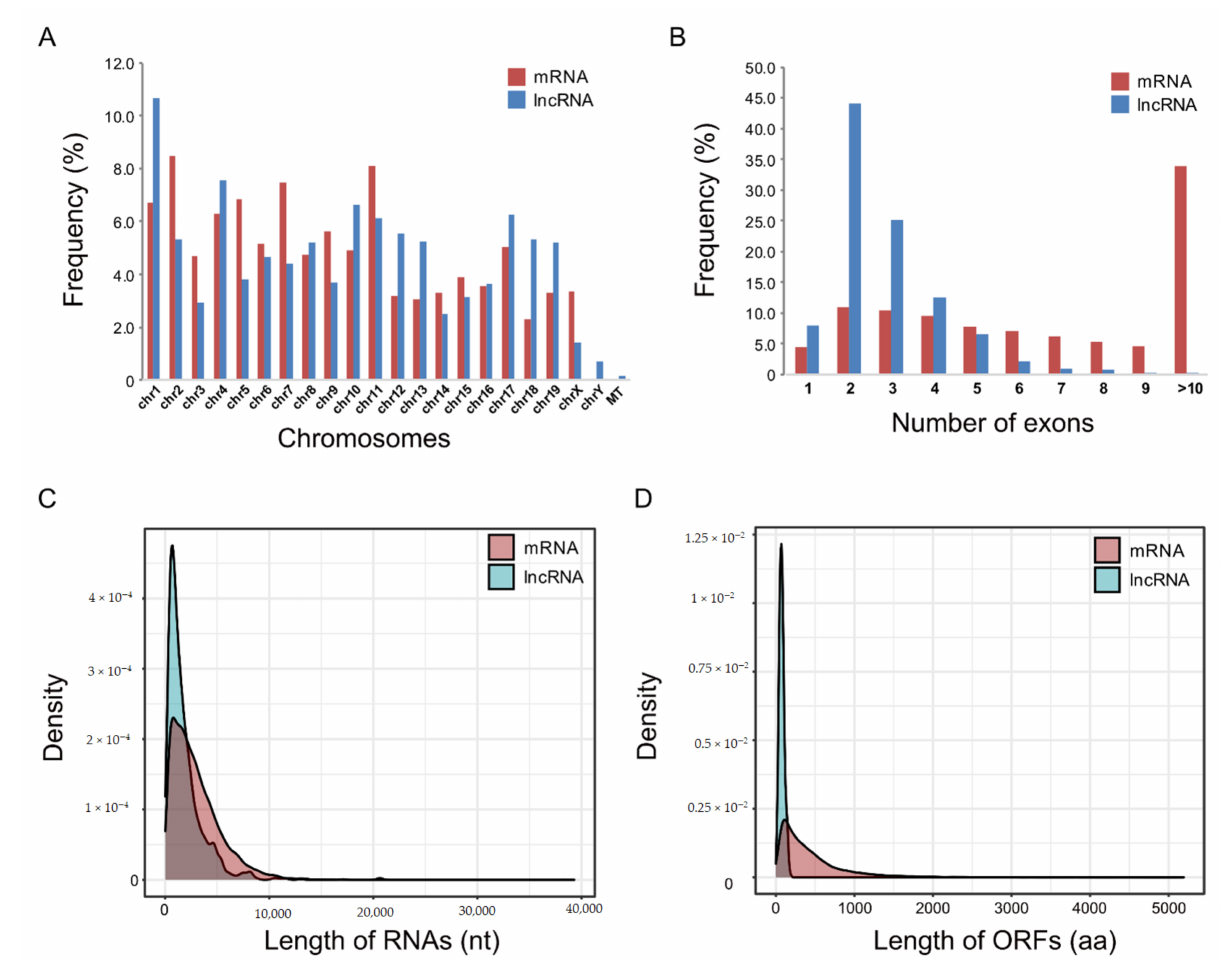
Figure 2. Comparison of sequence features of differentially expressed mRNAs and lncRNAs in muscle atrophy conditions. ( A ) Genome-wide distribution of differentially expressed mRNAs (red) and lncRNAs (blue) on mouse chromosomes; MT, mitochondria. ( B ) Frequency of numbers of exons in differentially expressed mRNAs and lncRNAs. ( C ) Transcript length distribution of differentially expressed mRNAs and lncRNAs; nt: nucleotide. ( D ) Distribution of open reading frame (ORF) lengths of differentially expressed mRNAs and lncRNAs; aa: amino